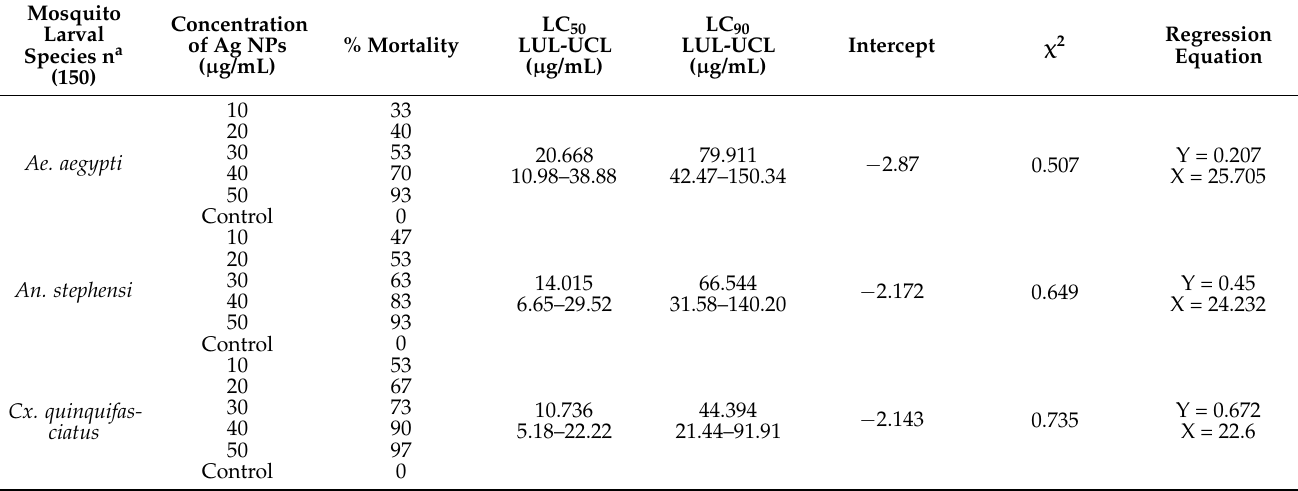
Table 2. Larvicidal activity of Priestia aryabhattai -mediated Ag NPs against 4th-instar larvae of major mosquito